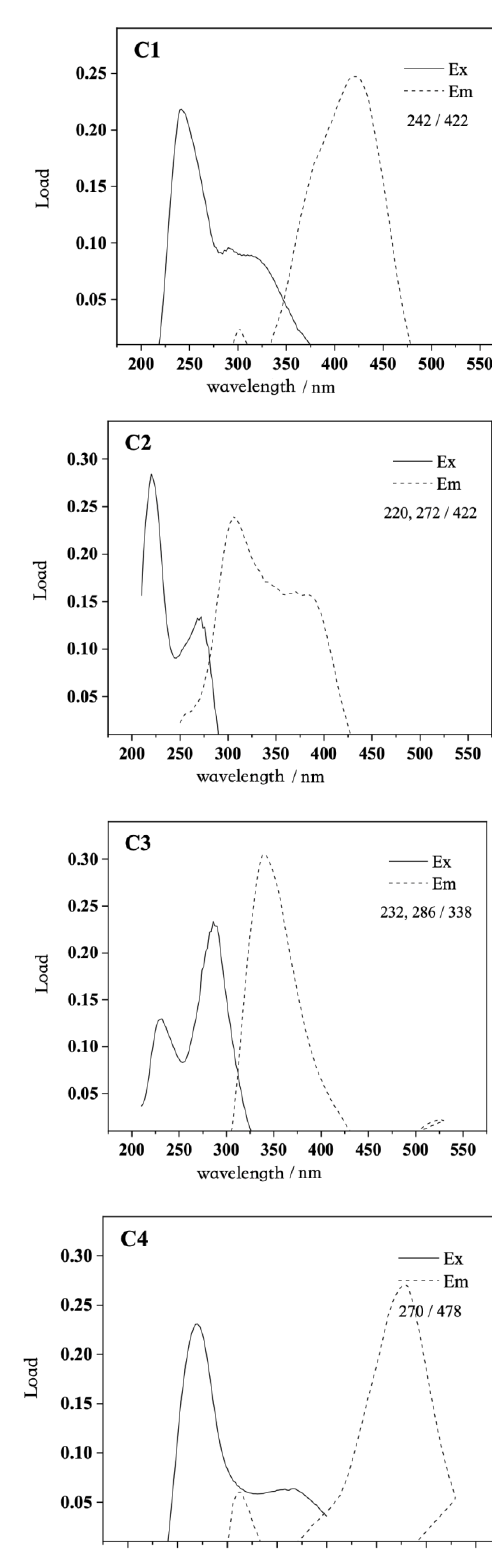
11 of 18 Figure 11. Spatial distribution characteristics of the CDOM concentration (a 254 , m −1 ) in the water body of Qinghai Lake in different seasons. (2) Fluorescence spectra and fluorescence component characteristics of FDOM